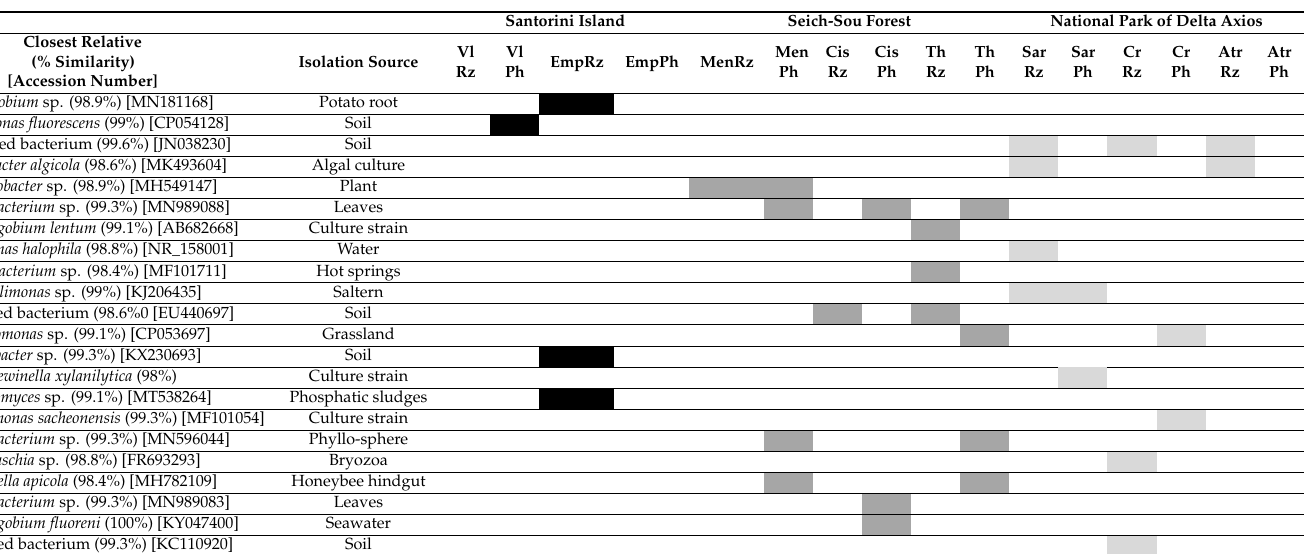
Table 4. The OTUs identified as being abundant specialists in the entire dataset, their putative high-level taxonomic a ffi liation, their closest relatives based on BLAST searches against the SILVA database and confirmed against NCBI database, and the isolation source of the closest relative. Shaded boxes denote high relative abundance; i.e > 20% of the sample’s total number of reads on average of total sampled individuals in each occasion and di ff erent shading colours represent di ff erent locations; i.e., black denotes Santorini Island; grey, Seih-Sou forest; light grey, the National Park of Delta